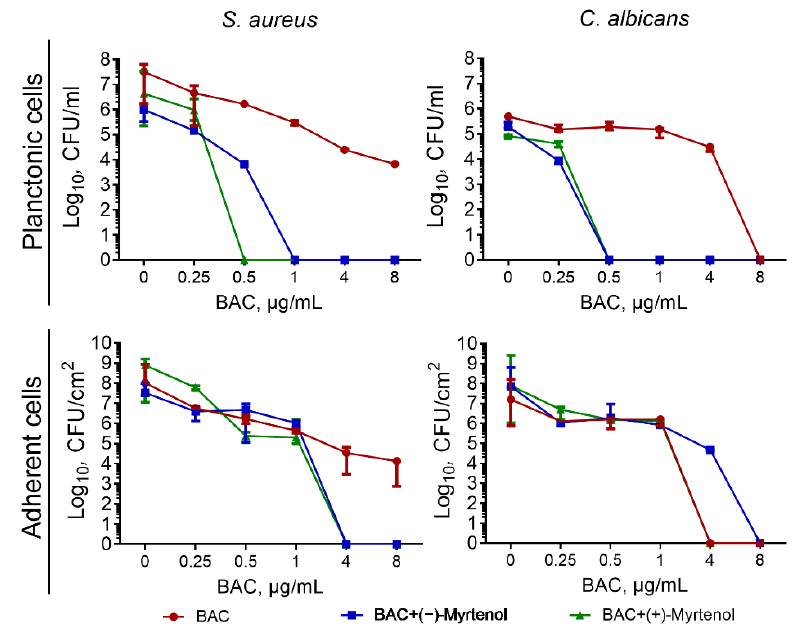
Figure 1. Viability of S. aureus and C. albicans in mixed culture in presence of benzalkonium chloride with concentrations 0, 0.25, 0.5, 1, 4, and 8 µg/mL separately and in combination with ( − )-myrtenol and (+)-myrtenol at a concentration of 256 µg/mL. The viability of bacterial and fungal cells was assessed after 24 h growth in culture liquid and after 48 for adherent cells. The viable cells were counted after a series of ten-fold dilutions followed by plating on selective media for differentiation of S. aureus and C. albicans .